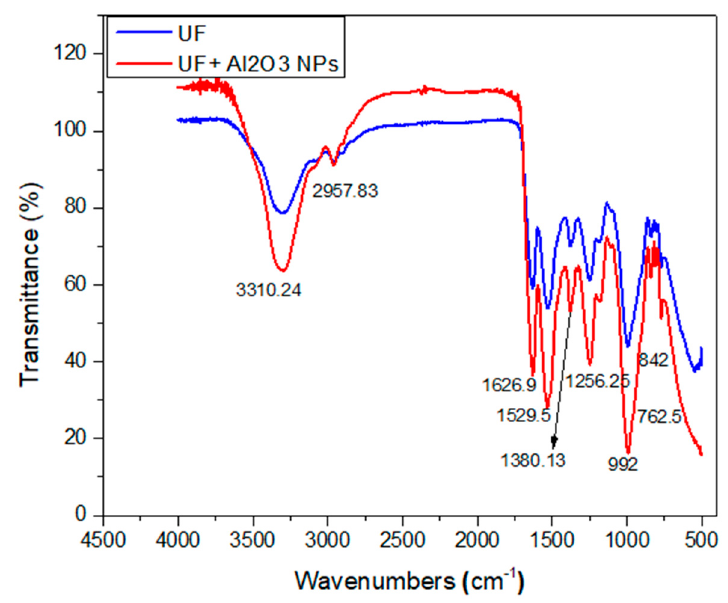
Figure 7. Fourier transform infrared spectroscopy of urea-formaldehyde with or without alumina